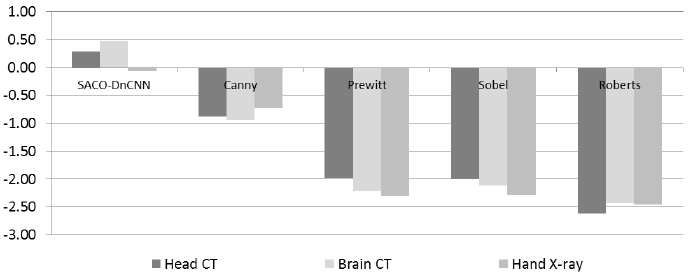
Figure 4. Comparison of the best SACO-DnCNN, Canny, Prewitt, Sobel, and Roberts methods on the Head CT, Brain CT and Hand X-ray medical